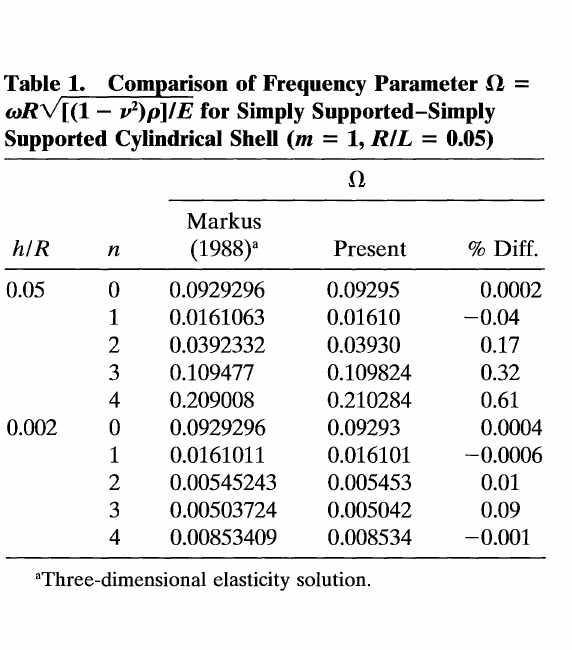
Table 4. Frequency Parameter 0 = wRY[(I- p2)p]IE for Simply Supported-Simply